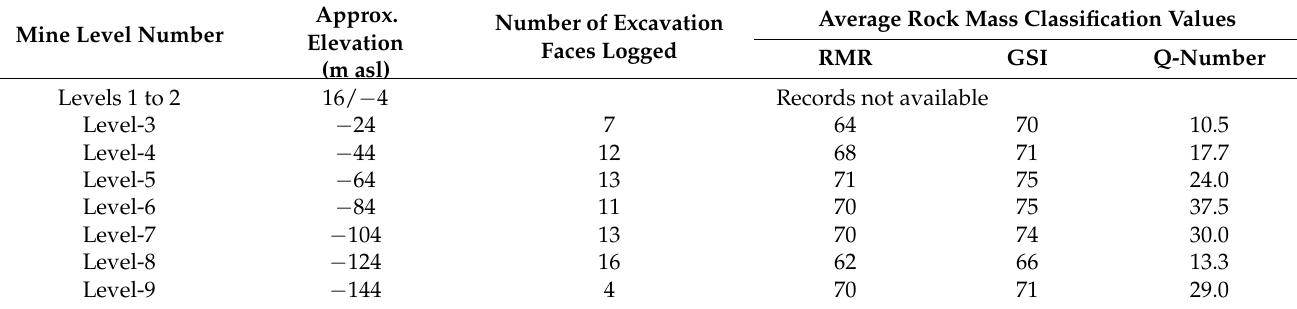
Table 4. Summary of Rock Mass Classification Values.